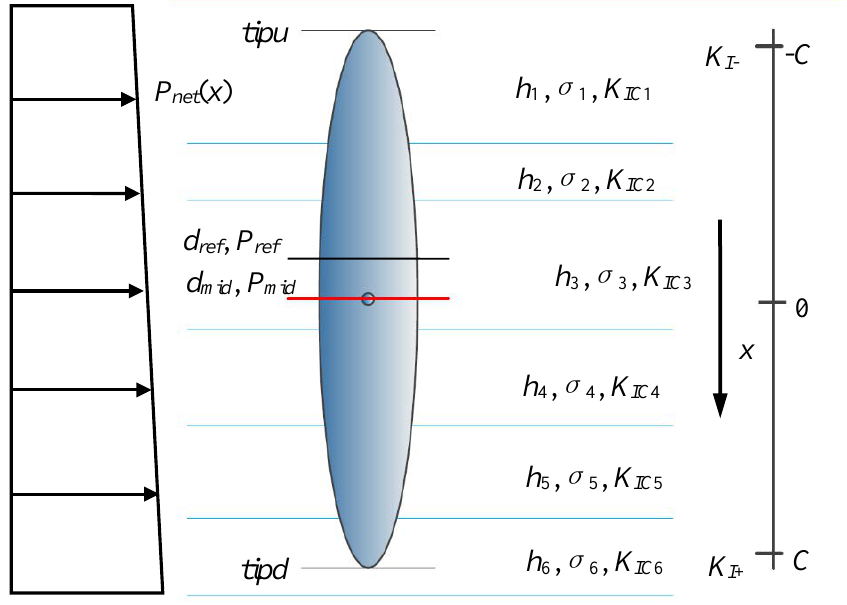
Figure 2. Physical model of vertical fracture extension.